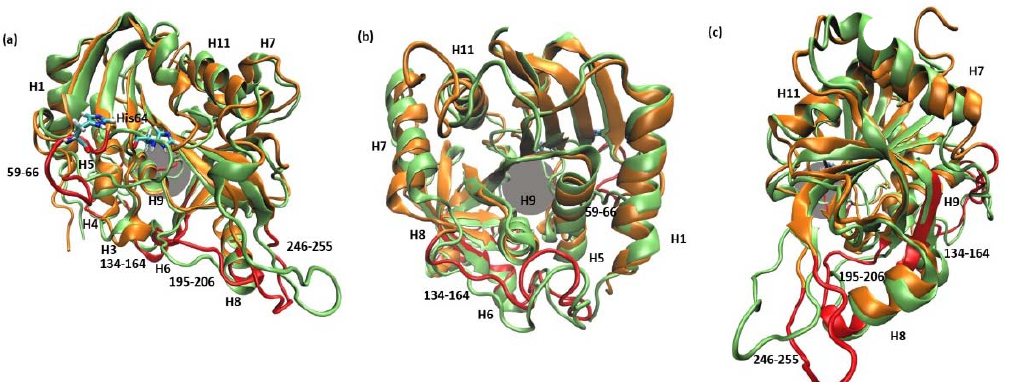
Figure 4. Superposition of two MD trajectory snapshots of the WT1 PNP (orange) and one subunit of WT3 PNP (green). The gray area marks the approximate location of the active site. The largest displacements between both variants are marked red and involve: the loop 59–66, on which His64 is placed, best visible on panel ( a ) (His64 side chain in both enzyme variants is shown, colored by the atom types); a large loop belting the monomer from one side and spanning residues 134–164, best visible on panel ( b ); and the helix 195–206 and the loop 246–255, which are placed adjacently, as well as on the other side of the inter-dimer interface from the loop 134–164, see panels ( a , c ). The exemplary snapshots are after 150 ns of MD simulation.